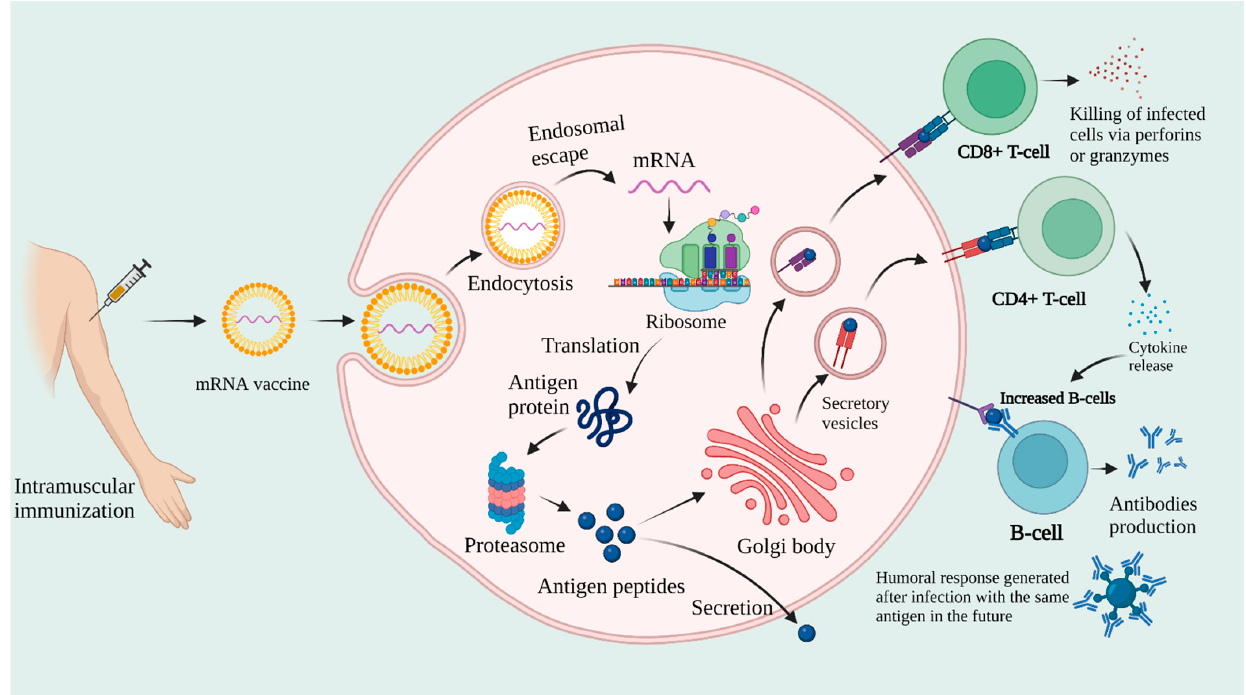
Figure 4. Mechanism of action of mRNA vaccines postvaccination.